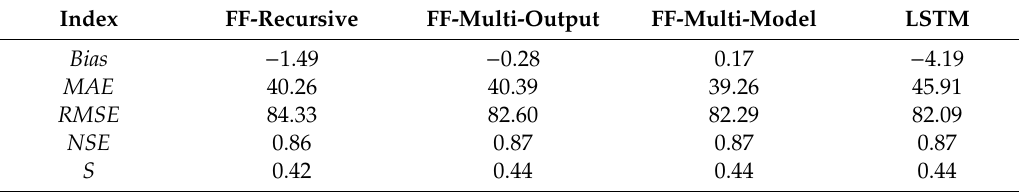
Table 3. Average performances of FF and LSTM predictors on the first 3 hours (whole day).